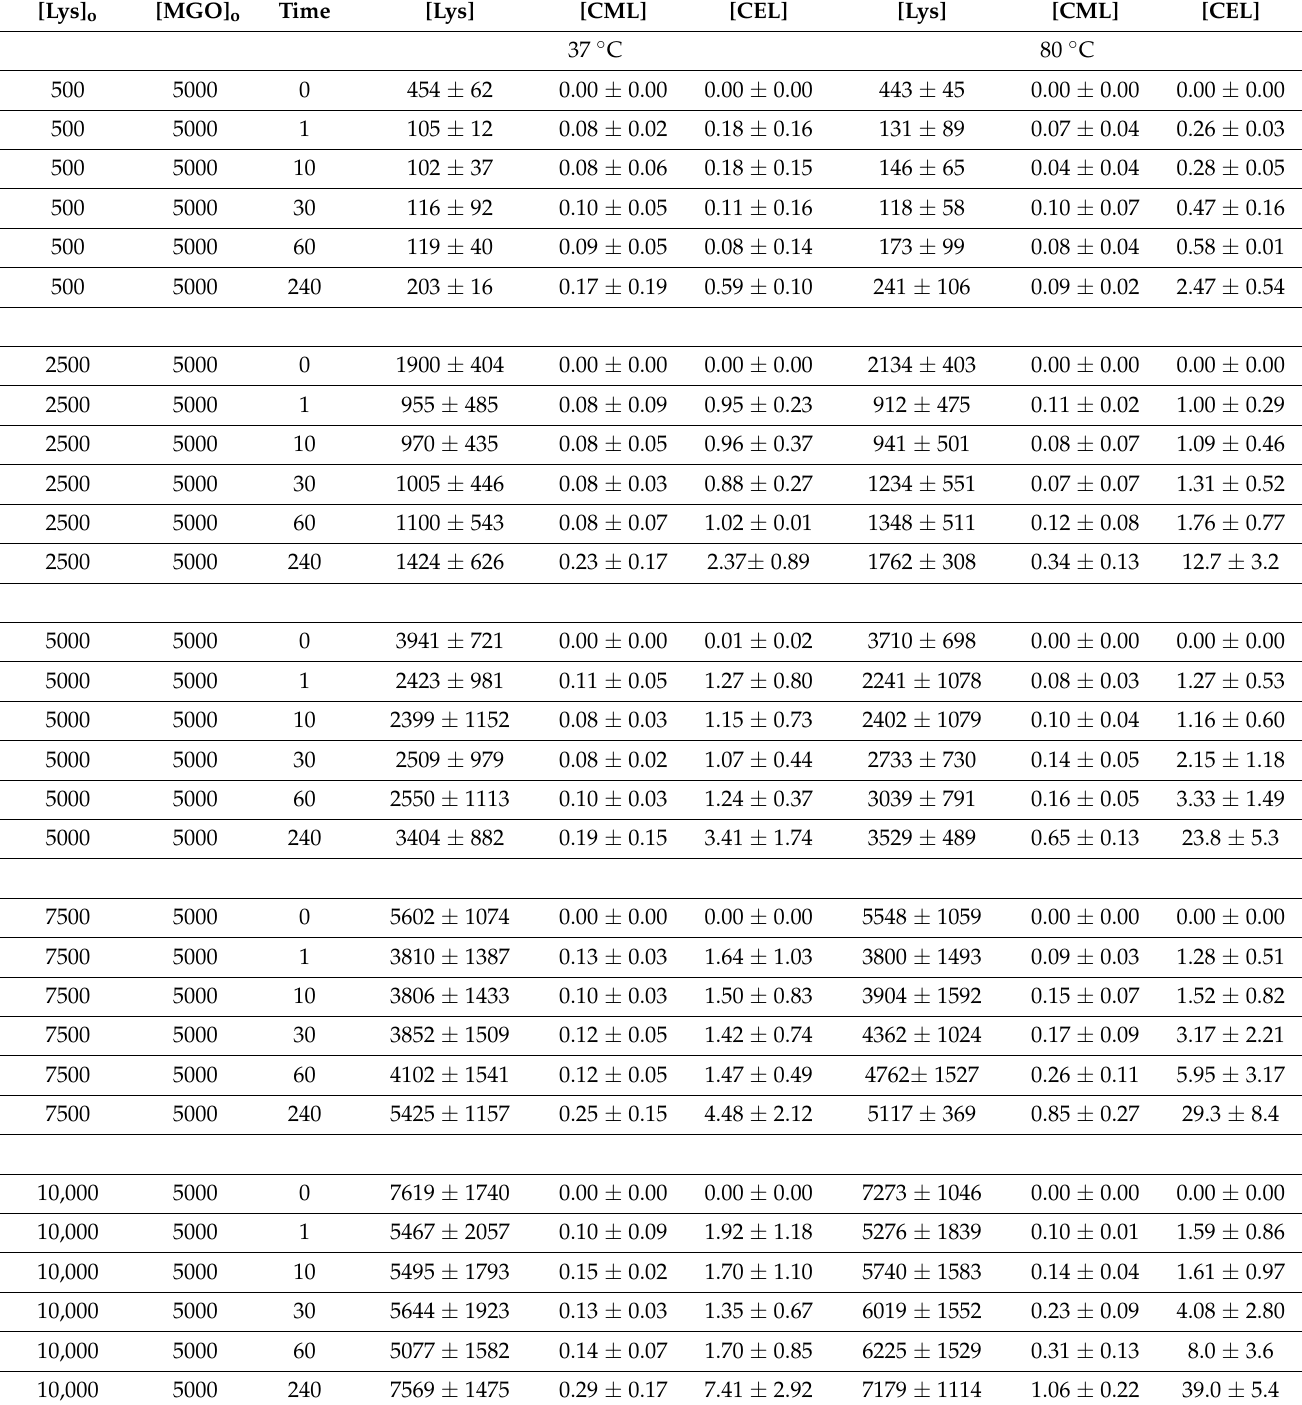
Table 2. Concentration (mean ± SD; µ M) of remaining Lys and formed CML and CEL from